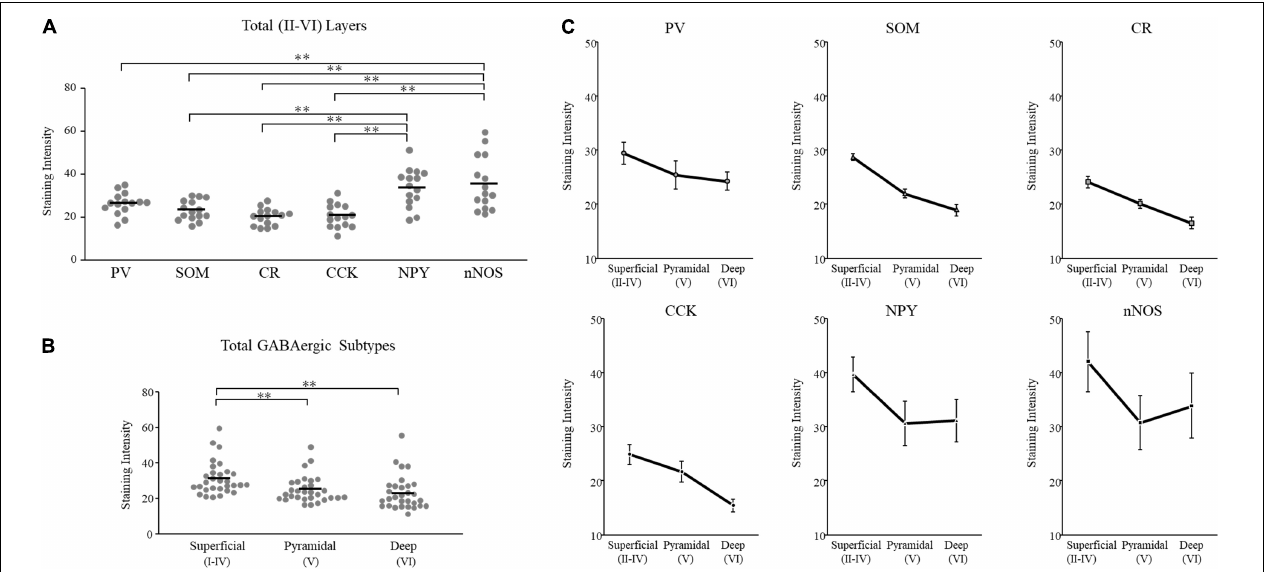
FIGURE 3 | GAD65 expression in each GABAergic subtype across layers of the cerebral cortex ( n = 5 brains). The average intensity of GAD65 immimostaining among six GABAergic subtypes (A) . The average intensity of GAD65 immunostaining among the superficial (II–IV), pyramidal (V), and deep (VI) layers (B) . The average intensity of GAD65 immunostaining across layers of the cerebral cortex among six GABAergic subtypes (C) . Error bars indicate SEM. Two-way ANOVA followed by Bonferroni’s tests was used to compare the expression level. ∗∗ p < 0.01.